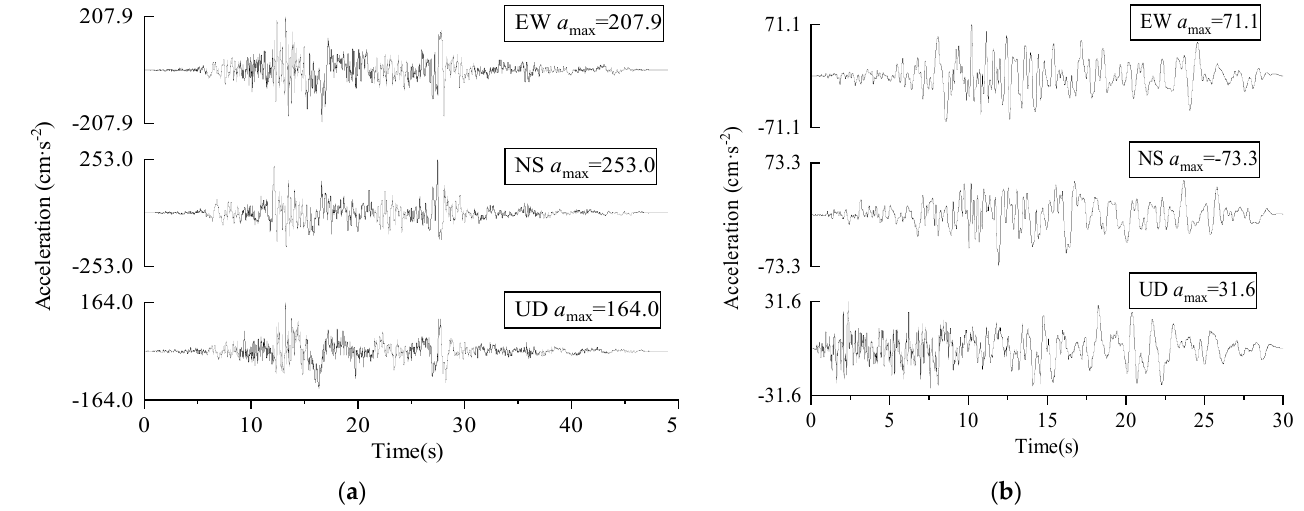
Figure 2. Acceleration time − history of Chi − Chi and Loma Prieta ground motion. ( a ) Chi ‐ Chi; ( b ) Loma Prieta. Table 1. Chi ‐ Chi and Loma Prieta ground motion waveform information.